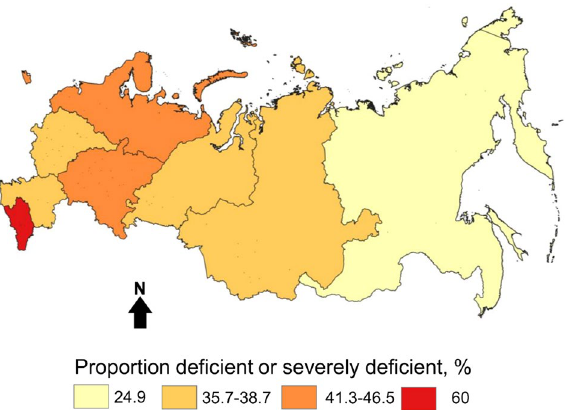
Figure 1. Proportion of sample with severely deficient or deficient 25(OH)D concentrations (< 20 ng/mL) by Federal District. Data are from 2013 to 2018 and are from all months of the year. The map was produced by the authors using QGIS 3.10 (https:// www. qgis. org) a free and open-source desktop Geographic Information System application.